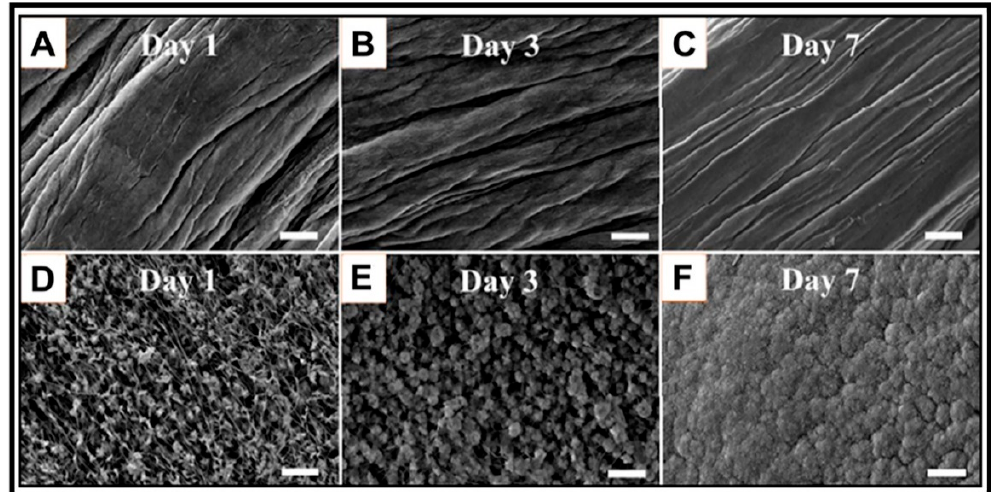
Figure 6. SEM images for the SBF-mineralization of bioglass 45S5-incorporated electrochemically aligned collagen (BG-ELAC) scaffolds. ( D – F ) showed increased mineralization crystals compared to the smooth surfaces of ( A – C ), respectively. Adapted with permission from [105].